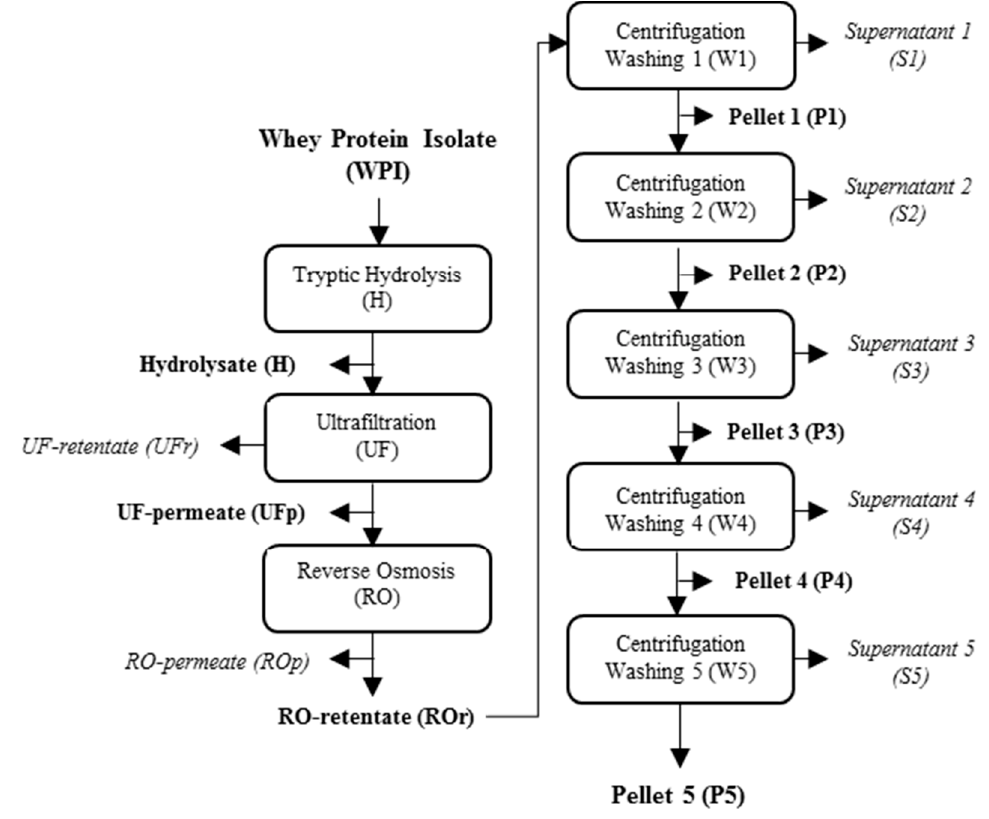
Figure 3. Flow chart of the process for the production and purification of Pf1-8.